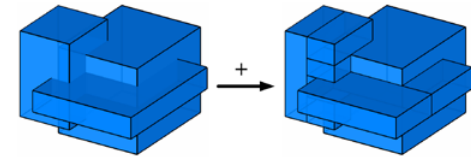
Fig. 4. Addition operation .